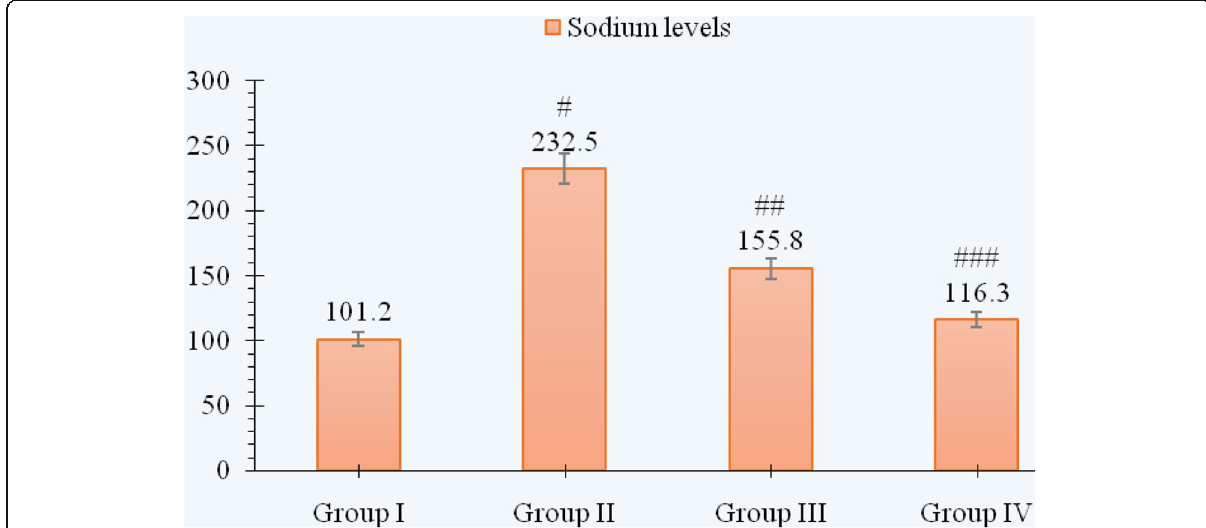
Fig. 8 Sodium levels of various groups. # p < 0.001 as compared to group I, ## p < 0.05 as compared to group II and ### p < 0.01 as compared to